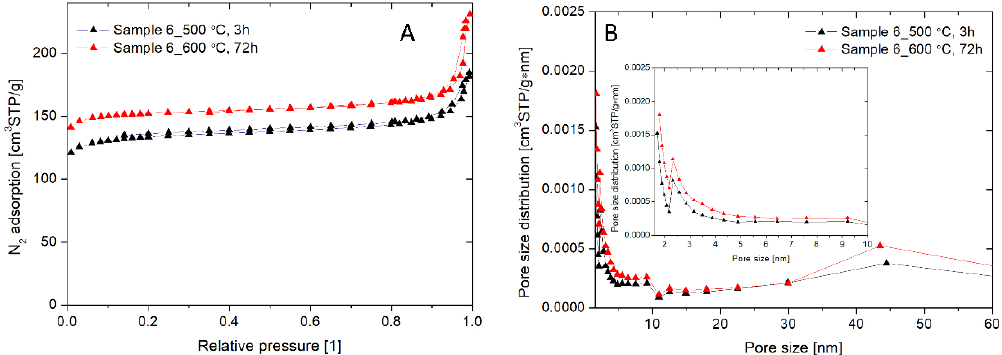
Figure 4. The e ff ect of time and temperature of calcination on porous parameters of NaA nanozeolite (sample 6). ( A ) low-temperature nitrogen adsorption isotherms, ( B ) pore size distributions. Inset shows pore size distributions in the range from 0 to 10 nm. Table 3. The e ff ect of time and temperature of calcination on porous parameters of NaA nanozeolite (sample 6). S BET -surface area, V t -total (single-point) pore volume obtained from the amount adsorbed at p / po = 0.99, D ave -average pore diameter, V micro -micropore volume (pores < 2 nm), and microporosity.